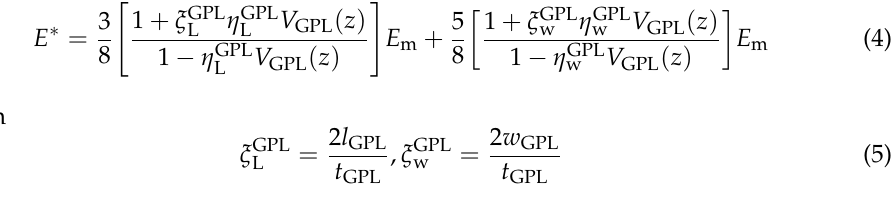
Figure 2. Cross-section of a single GPLRP, cylindrical panel for different porosity distributions. ( a ) Porosity-I; ( b ) Porosity-II; ( c ) Porosity-III .